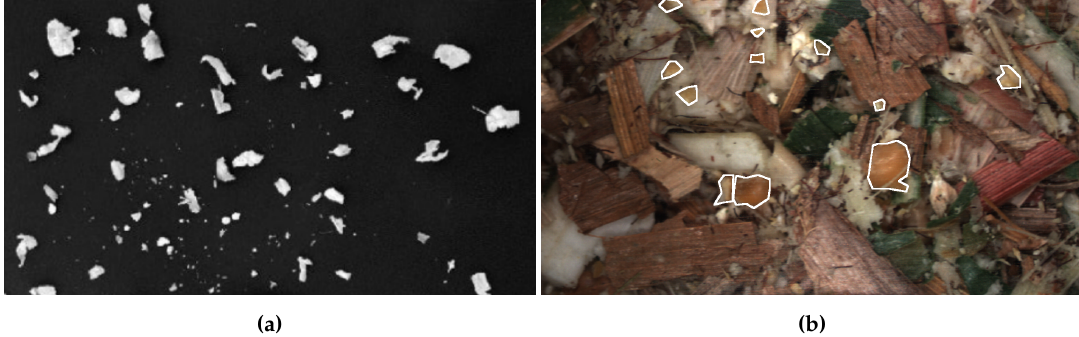
Figure 1. Example of the difference in images between separated and non-separated corn silage. ( a ) Reprinted from [6], with permission from Elsevier; ( b ) Example image from this